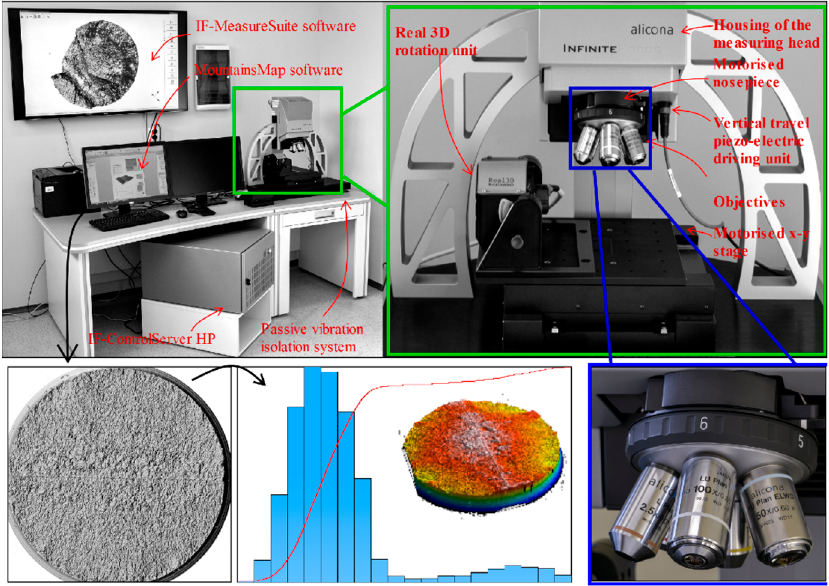
Figure 4. InfiniteFocus IF G4 measurement device used in surface metrology and The Abbott-Firestone curves (middle bottom picture).